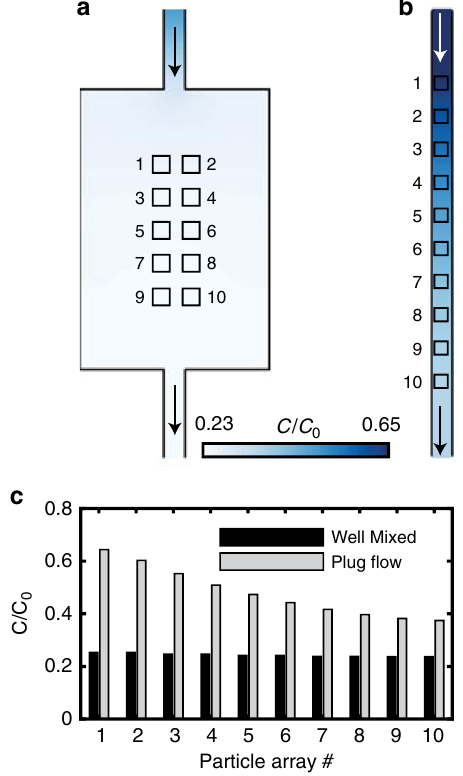
Fig. 2 Simulated O 2 concentration pro fi les inside the two catalyst bed geometries. Concentration pro fi les presented as colored surfaces for a the well-mixed reactor and b the plug- fl ow reactor illustrating the small / large variations in the well-mixed/plug- fl ow reactor, respectively. c The reactant concentration relative to the inlet (C 0 ) at each of the particle array patches for the two designs. Numbers on the x -axis correspond to the numbers in ( a ) and ( b ). In all simulations, the active catalyst is simulated as patches on the wall with a fi rst-order surface reaction, the rate of which (same for both reactor geometries) is chosen so as to match the experimentally observed global conversion over the reactor (see Supplementary Methods for details). The fl ow through the system was set to 1.5 × 10 12 s − 1 , based on experimentally measured fl ow